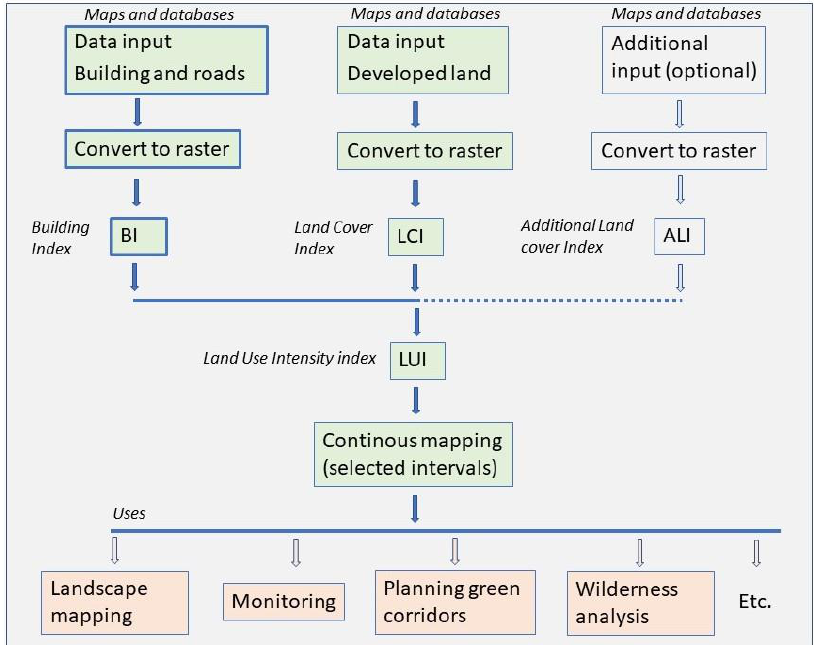
Figure 2. An overview of the procedure of calculating LUI with its components.